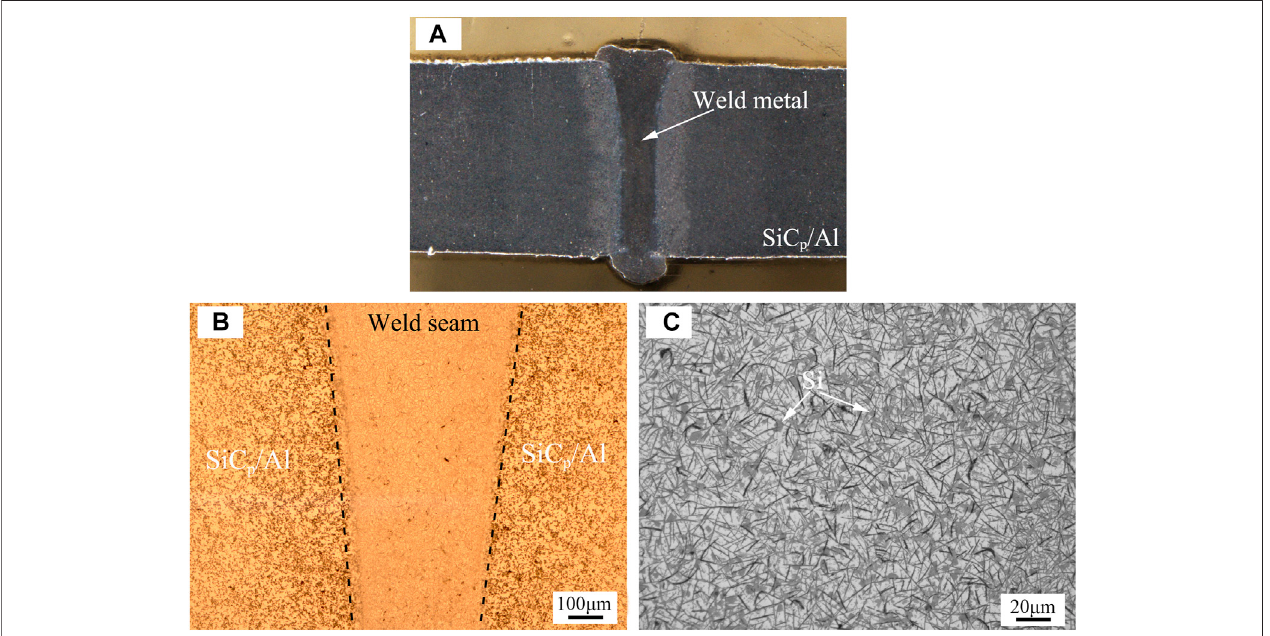
FIGURE 7 | Cross-section and optical micrographs of SiCp/6061Al laser welded joint with Ti interlayer: (A) cross section of the joint (B) microstructure of the weld seam (C) enlarged view of weld metal.